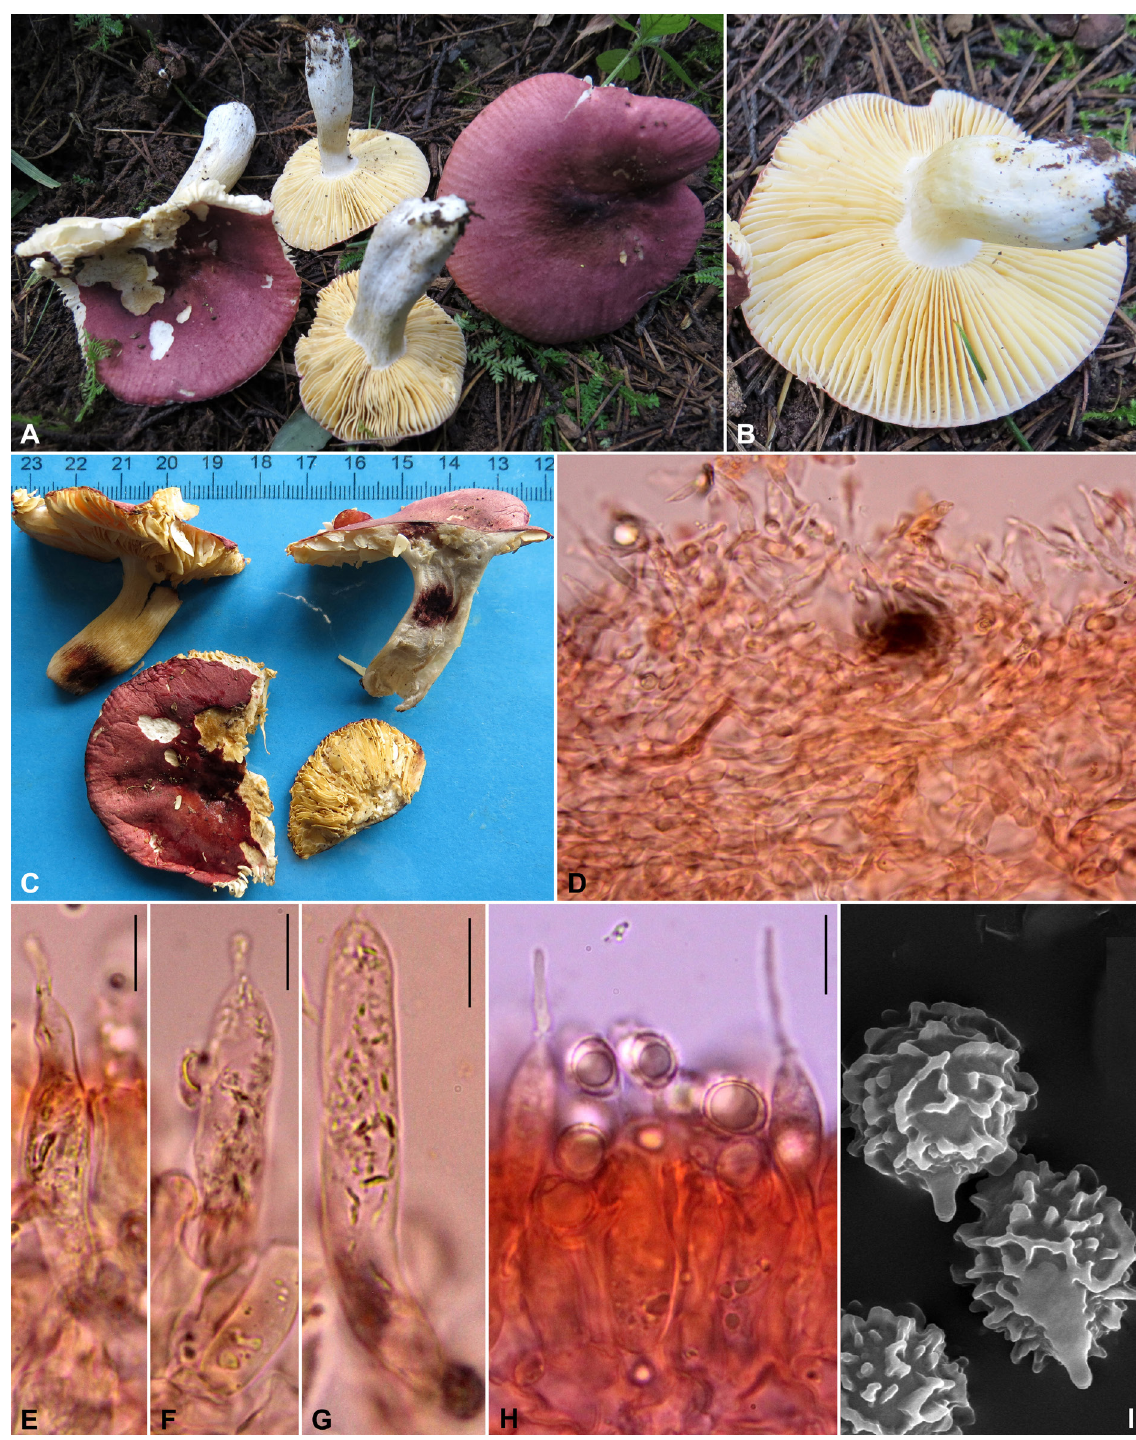
Fig. 2. Russula adwanitekae A.Ghosh, K.Das & Buyck sp. nov. (from holotype, AG 16-1430 ). A–C. Fresh and dissected basidiomata in the field and basecamp. D. Transverse section through pileipellis showing elements. E–H. Transverse section through lamellae showing hymenial cystidia near the lamellae sides and basidia. I. SEM images of basidiospores. Scale bars: D–H = 10 μm; I = 2